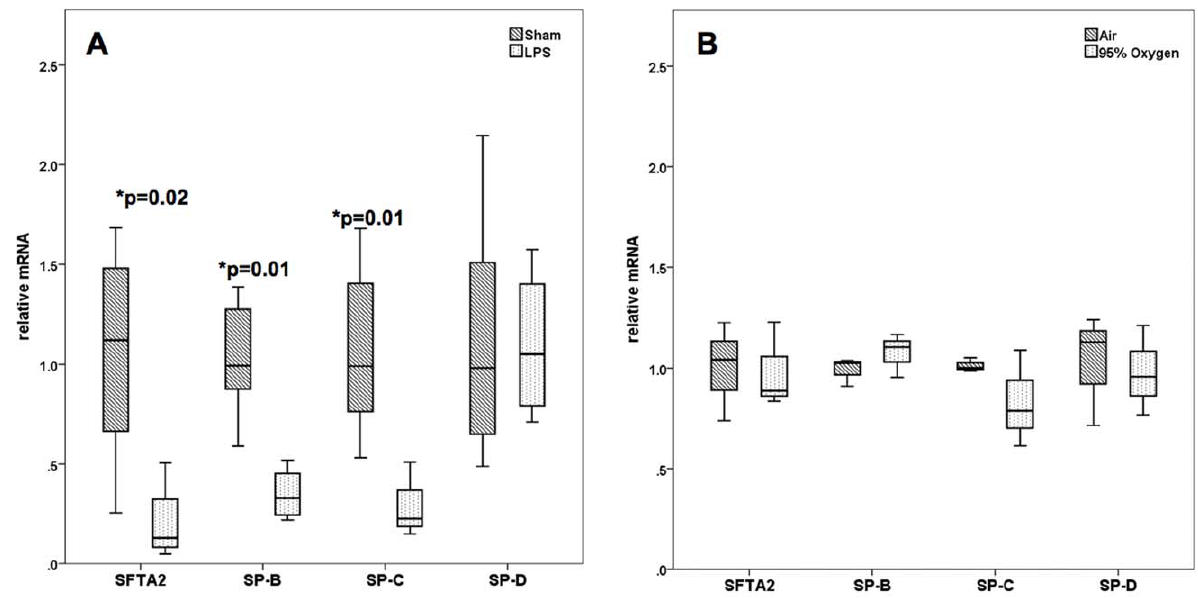
Figure 7. Analyses of specific mRNA levels in mouse lung in response to challenges by lipopolysaccharide instillation or oxygen exposure. The mean values of untreated animals were set to 1.0. A. Sfta2 qRT-PCR of mouse lung tissue 18 h after tracheal LPS instillation in relation to other type II pneumocyte proteins SP-B, SP-C, SP-D. Significant SFTA2 downregulation was observed in LPS-treated mice paralleling SP-B and SP-C, but not SP-D. B. Analysis of the same transcripts after room air vs. 95% oxygen exposure. We observed alteration of SFTA2 and any of the other messages despite significant inflammatory reaction (not shown).